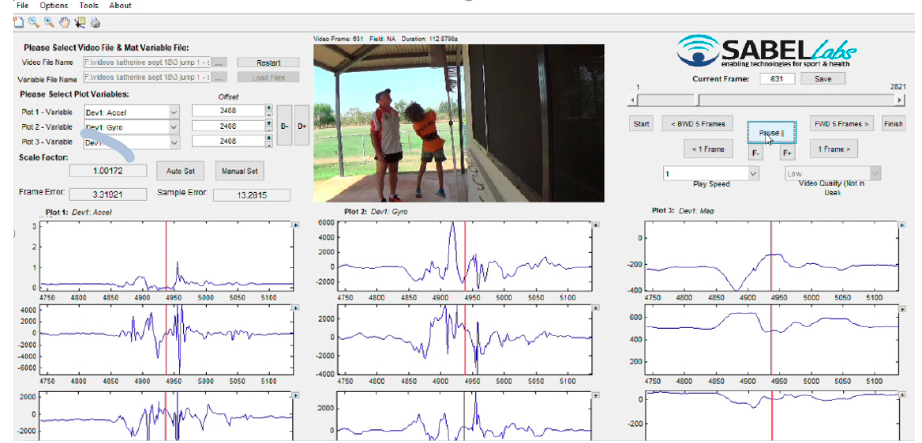
Figure 1. The student experience: A jump and reach task together with inertial sensors developed a strong sense of achievement and positive